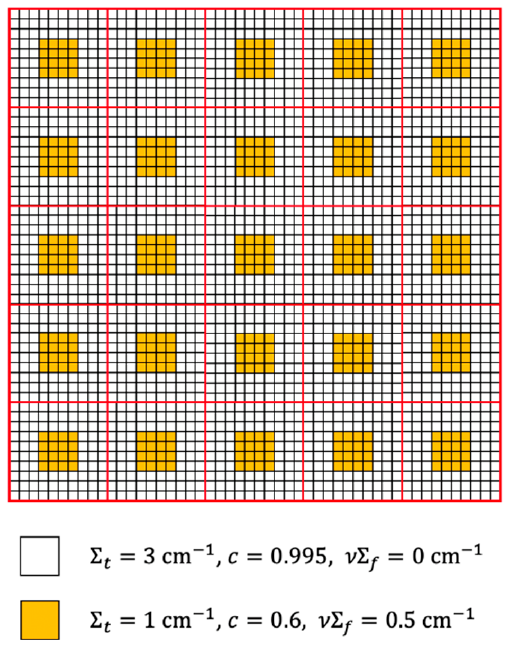
Figure 10. 2D mini-assembly problem. The normalized scalar flux is plotted in Figure 11a. The convergence comparison is illustrated in Figure 11b. In this problem, CMFD also fails to converge. The convergence of odCMFD is similar to that of modCMFD. Again, the lpCMFD scheme outperforms other schemes, and SOR can improve the convergence rate significantly.